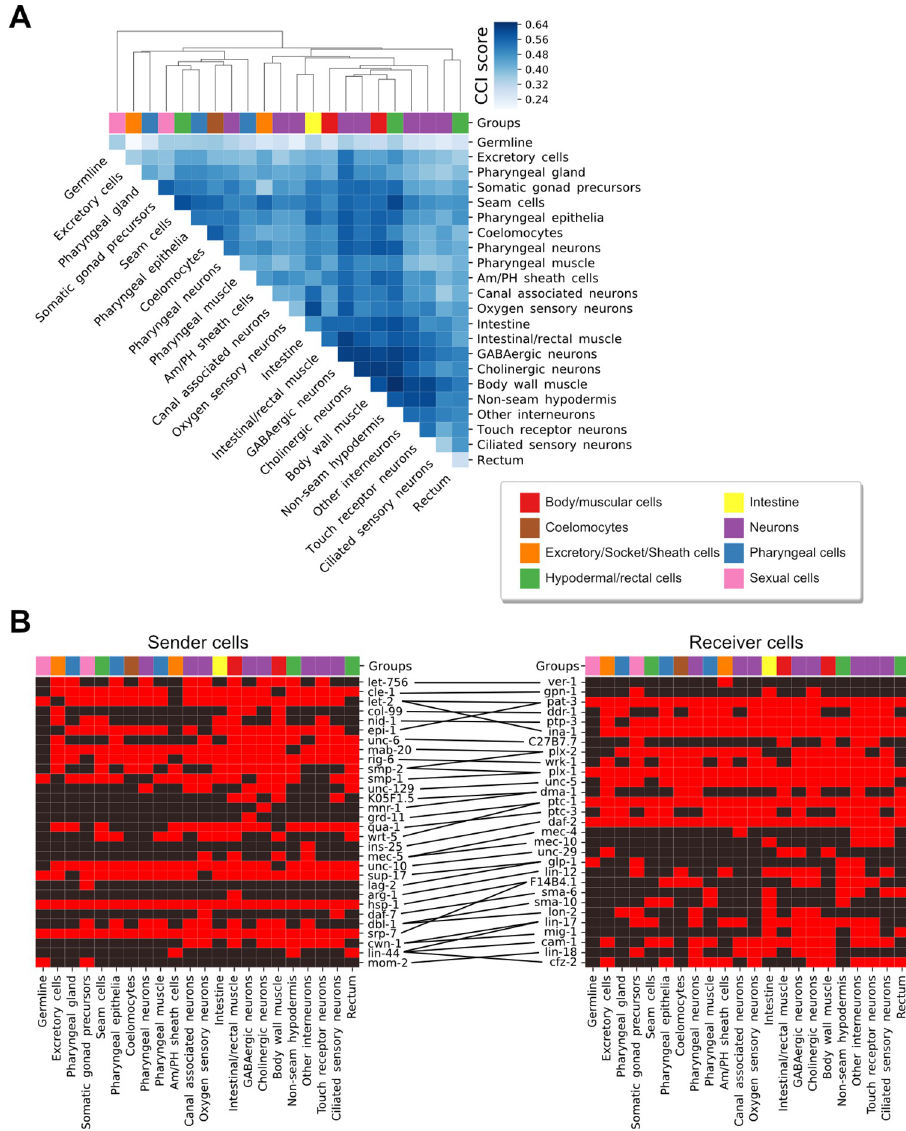
Fig 4. CCI analyses based on LR pairs associated with intercellular distances. (A) Heatmap of CCI scores obtained for each pair of cells using the consensus GA-LR pairs. An agglomerative hierarchical clustering was performed on a dissimilarity-like metric by taking the complement of CCI scores (1-score), excluding autocrine interactions. Cell types are colored by their lineage groups as indicated. (B) Heatmaps representing the presence or absence of ligands (left) and receptors (right) after expression thresholding ( > 10 TPM) in sender and receiver cells, respectively. Lines at the center connect ligands with their cognate receptors according to the GA-selected interactions. Cell types are colored as in